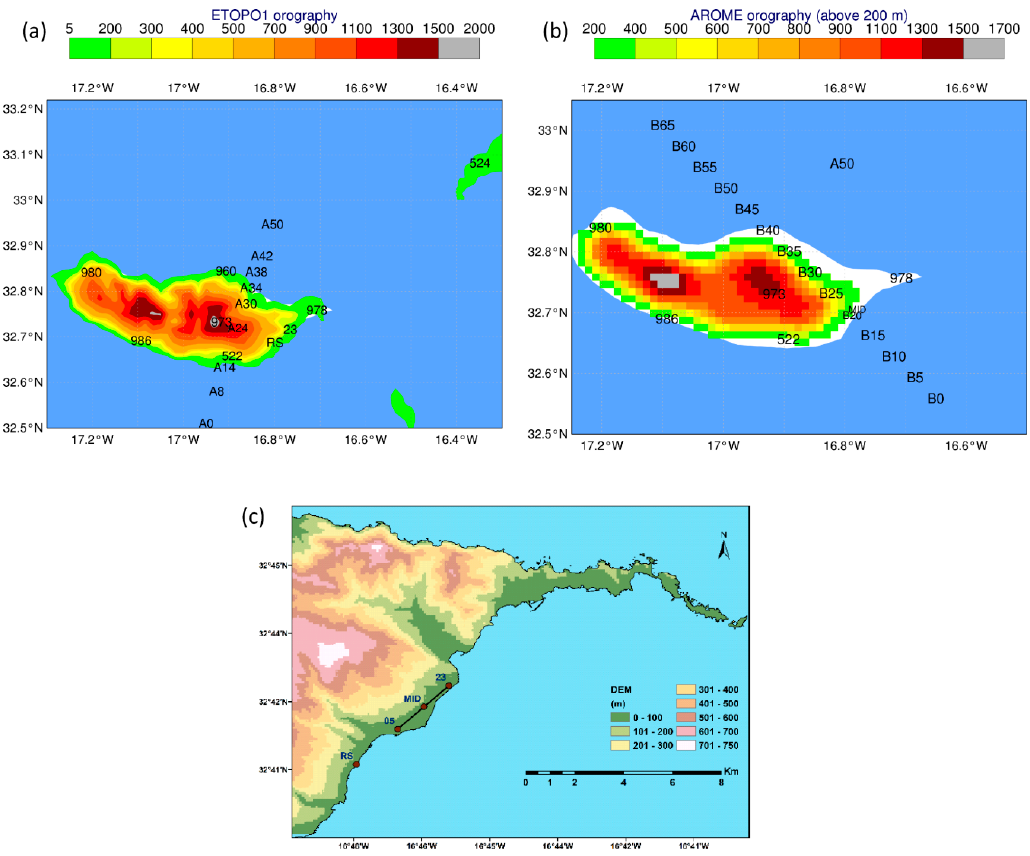
Figure 1. Hypsometric maps of the Madeira Island using the ( a ) ETOPO1 and ( b ) Application of Research to Operations at Mesoscale (AROME) orography. ( c ) Location of the CR Airport (solid black line) and the sites RS, 05, MID and 23, along with hypsometry from a digital elevation model (DEM) with 90 m spatial resolution (SRTM 90 m Digital Elevation Database v4.1).